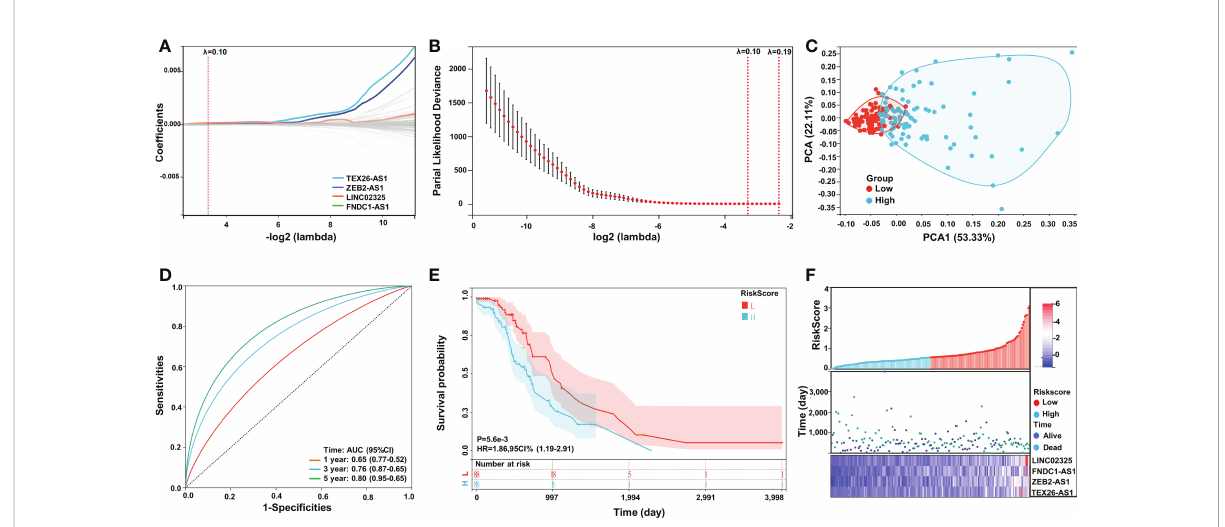
FIGURE 2 Construction and validation of the IRlncRNA prognostic risk model by LASSO regression analysis. (A, B) LASSO regression was performed with the minimum criteria. LASSO coef fi cient pro fi les of four prognostic IRlncRNAs (LINC02325, FNDC1-AS1, ZEB2-AS1, TEX26-AS1). (C) PCA plot. (D) ROC curve of the four-IRlncRNA signature for 1-, 3-, and 5-year survival in the TCGA cohorts. (E) Kaplan − Meier curves for the OS of PaCa patients in the high- and low-risk groups. (F) Risk score distribution, survival status and expression of four IRlncRNAs in PaCa